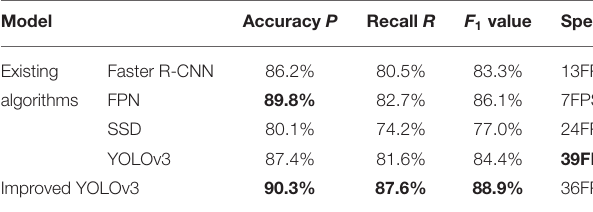
TABLE 1 | Soybean pod detection performance of different